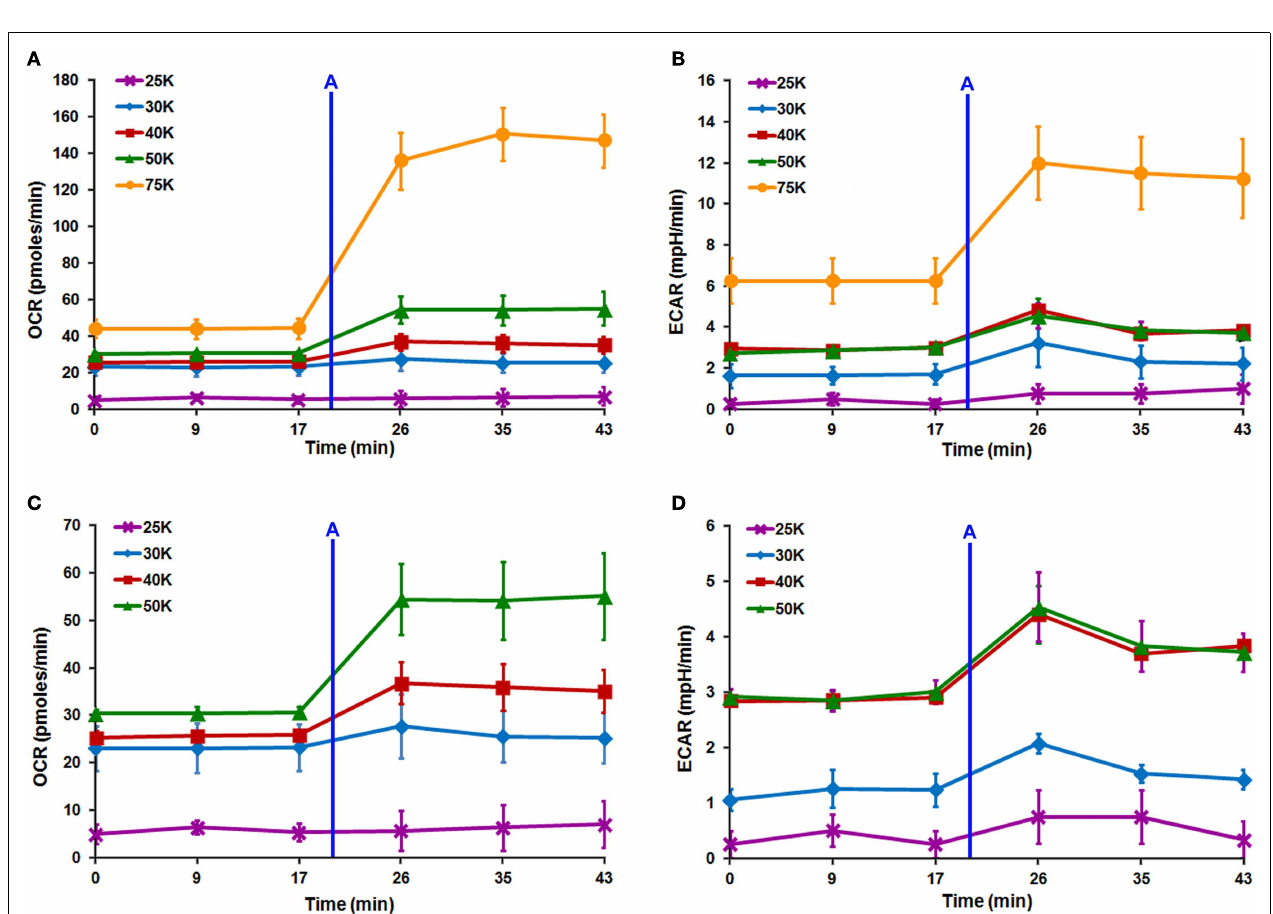
indicating the optimal seeding density for Seahorse XF24 analysis is likely 40,000 cells/well. After Seahorse XF24 mitochondrial stress analysis, XF24 microplates seeded at 40,000 cells/well showed minor detachment, thus, 50,000 cells/well was selected as the optimal density. Each data point is presented as mean ± SEM. All readings completed on polystyrene XF24 microplates pre-coated with 0.1mg/ml poly-lysine + 10% collagen. Injection (A) FCCP (0.5 µ